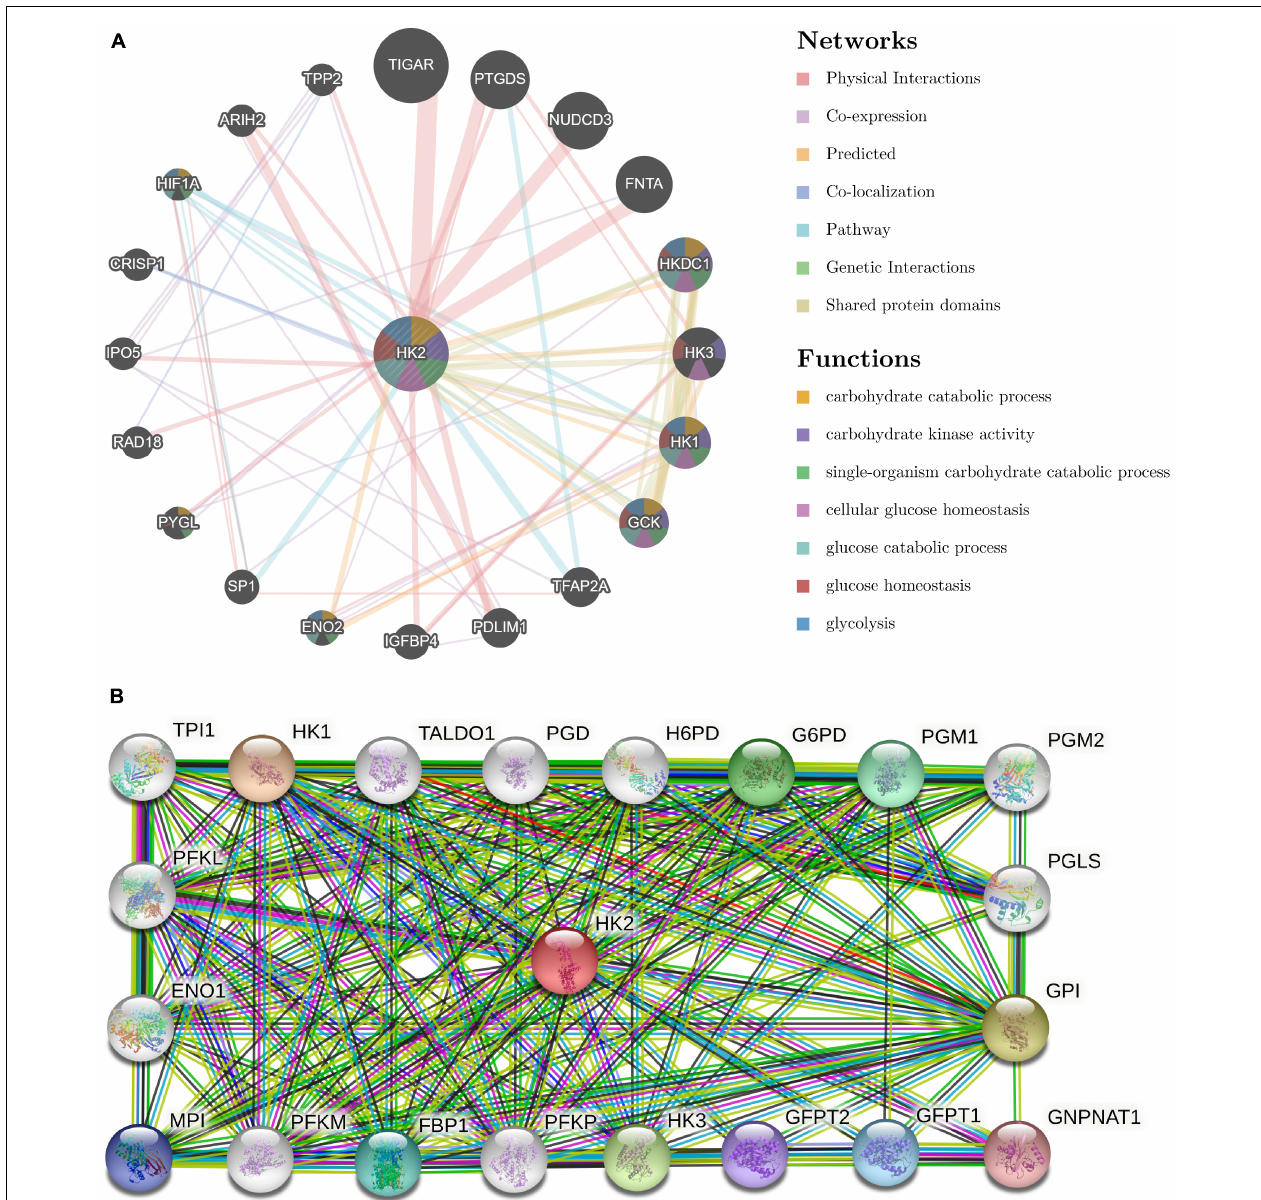
FIGURE 4 | Analysis of gene–gene interaction (GGI) and protein–protein interaction (PPI) of HK2 Gene. (A) GGI network of HK2. (B) PPI interaction network of